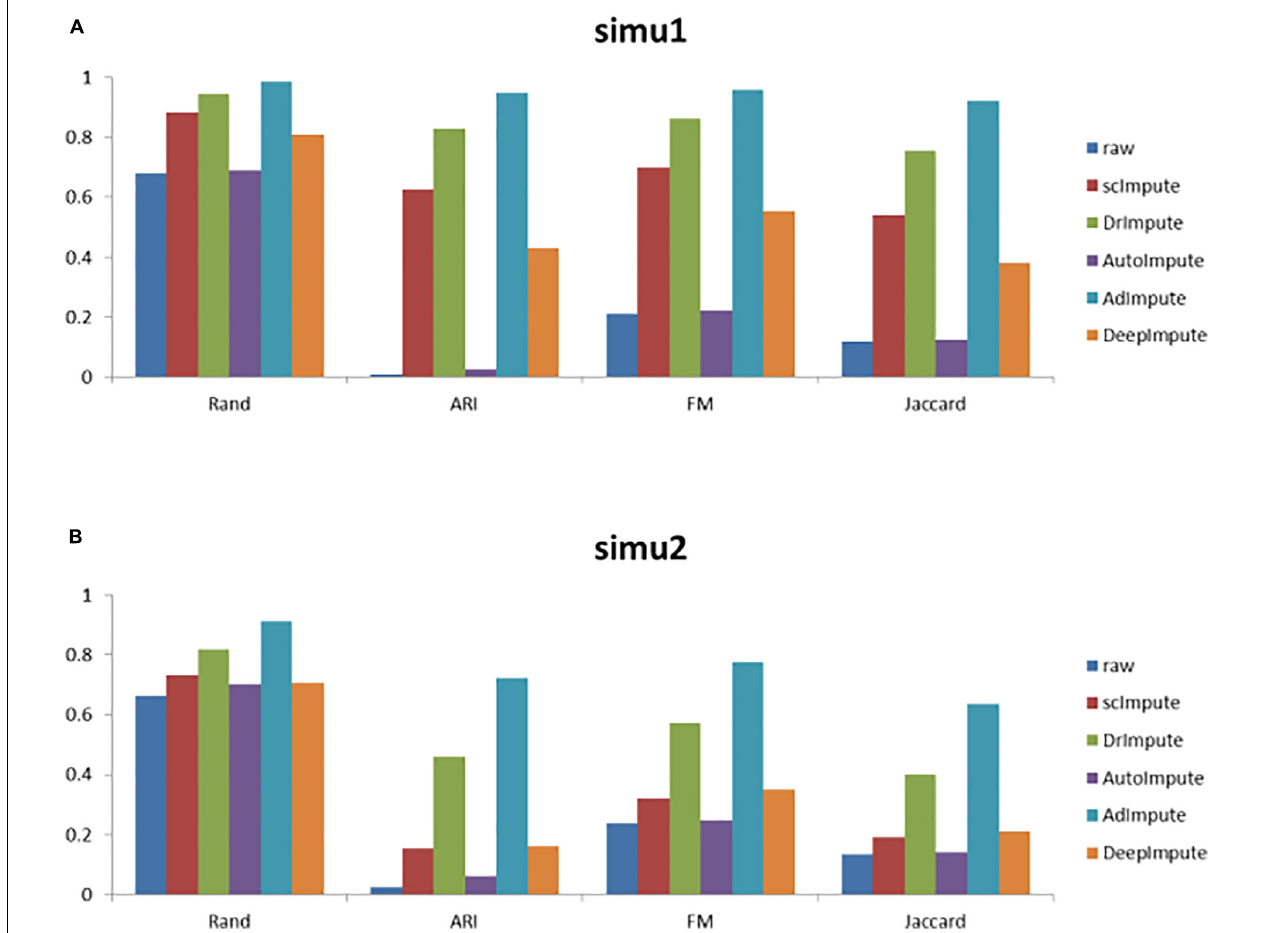
FIGURE 6 | The histogram of clustering evaluation indexes on the simulated data sets, including the clustering evaluation indexes of raw data and the clustering evaluation indexes after imputing by scImpute, DrImpute, AutoImpute, AdImpute, and DeepImpute. And (A) is the clustering evaluation indexes on simu1 data set; (B) is the clustering evaluation indexes on simu2 data set.